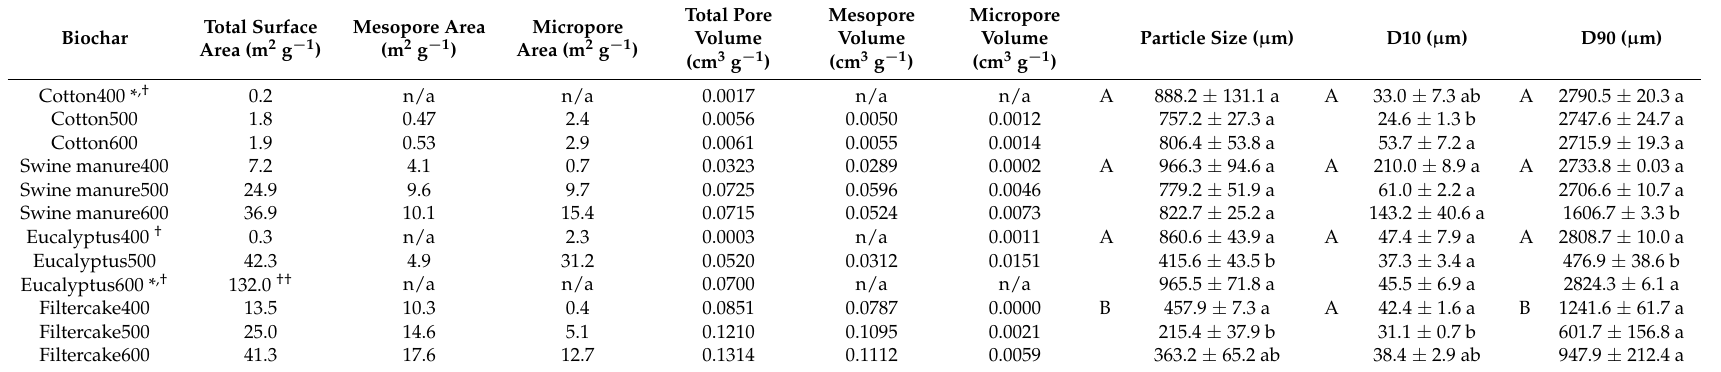
Table 4. Porosity determined by BET-N 2 sorption ( n = 1) and particle size and distribution of 12 biochars (4 feedstocks × 3 temperatures of pyrolysis). Micropores are identified as pores <2 nm diameter, mesopores as pores between 2 nm and 50 nm diameter. For particle analysis, capital letters indicate significant differences between the feedstocks and lowercase letters between the temperatures of pyrolysis for each feedstock ( n = 3; Tukey test, p <